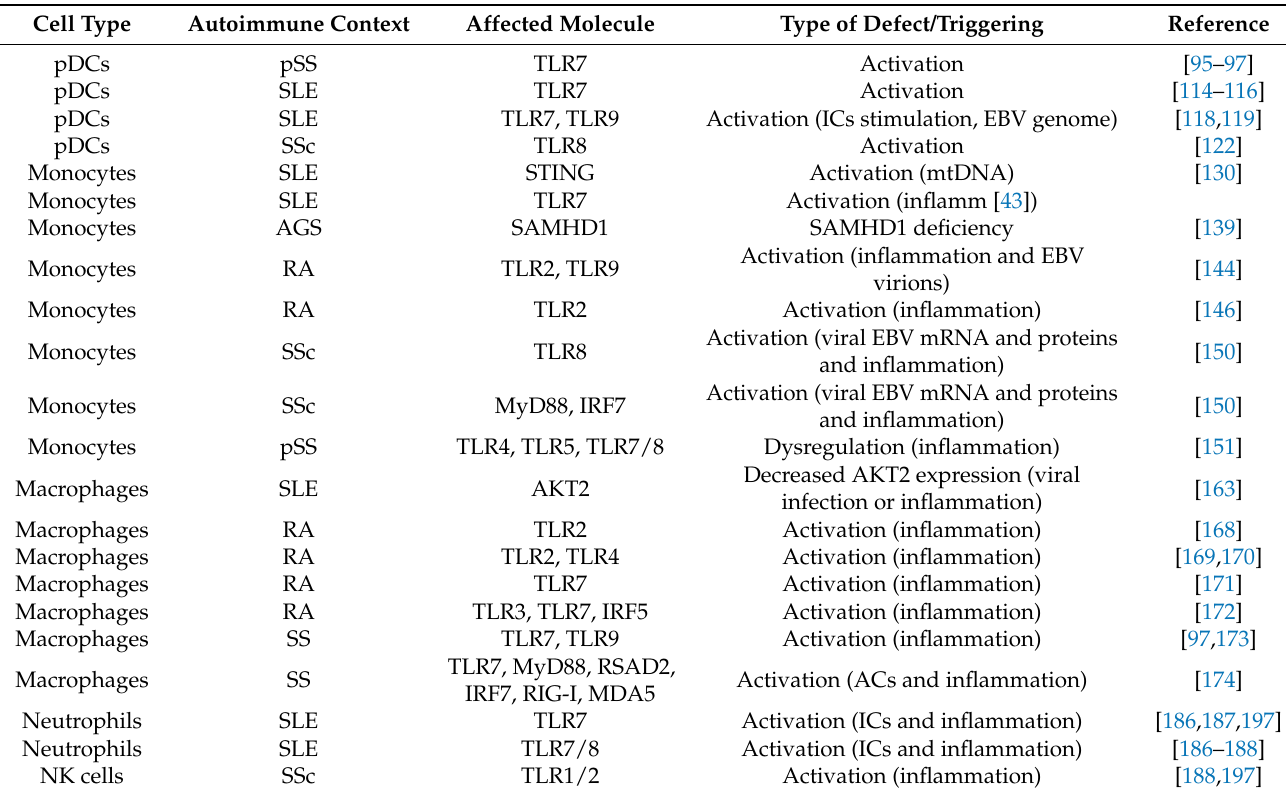
Table 1. Key findings in studies addressing PRR manifestations in innate immune cells in